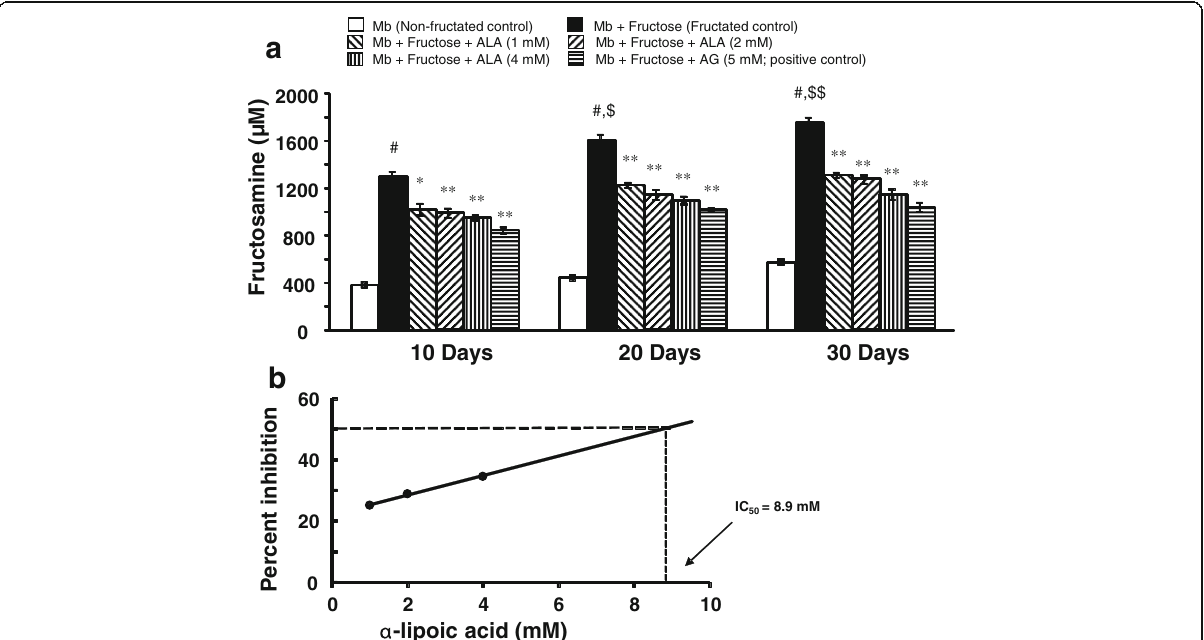
Fig. 3 Effects of α -lipoic acid on fructosamine formation in fructose-induced myoglobin fructation. Each bar represents the mean ± SEM in six separate experiments (n = 6). Significant difference compared to fructated control at identical times: * p < 0.05; ** p < 0.01. Significant difference from non-fructated control: # p < 0.001. Significant difference from the respective Day-10 value: $ p < 0.05; $$ p < 0.01. ALA = α -lipoic acid; AG = Aminoguanidine; Mb =